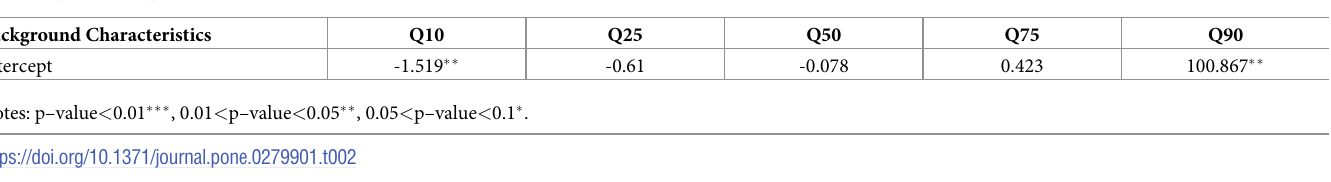
PLOS ONE | https://doi.org/10.1371/journal.pone.0279901 January 26,